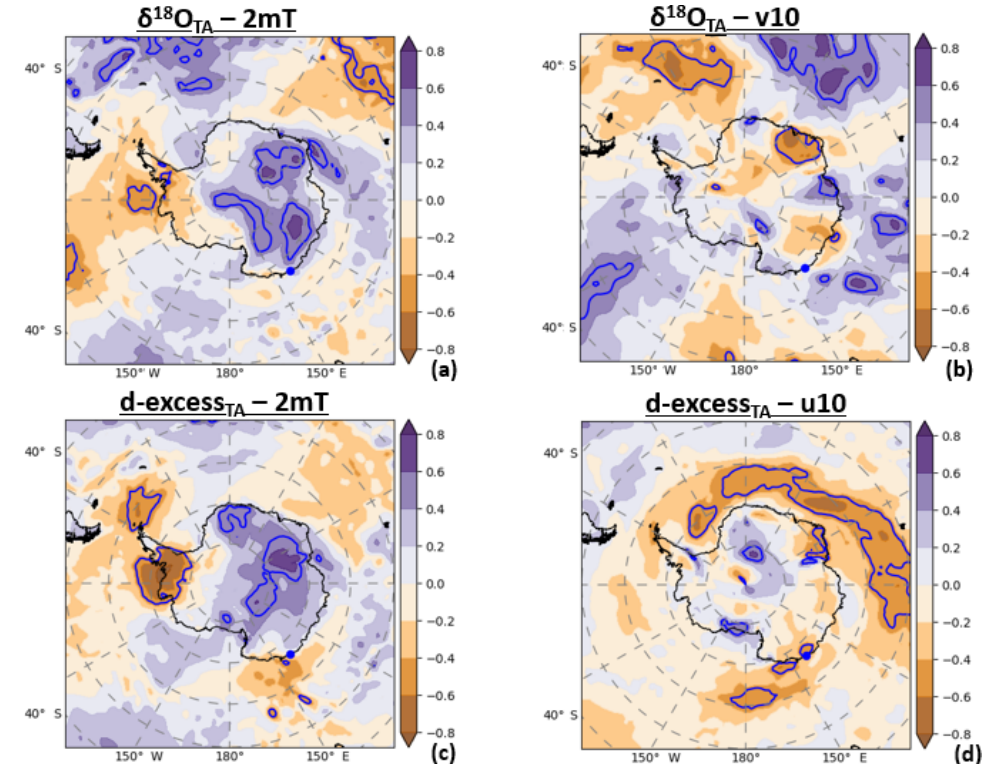
Figure 12. Coefficient correlation between the TA isotopic records and ERA-Interim reanalyses, (a) between δ 18 O TA and the 2m tem- perature, (b) between δ 18 O TA and the 10m v wind component, (c) between d -excess TA and the 2m temperature, and finally (d) between d -excess TA and the 10m u wind component. The blue point locates the TA192A drilling site, and the blue lines contour the significant